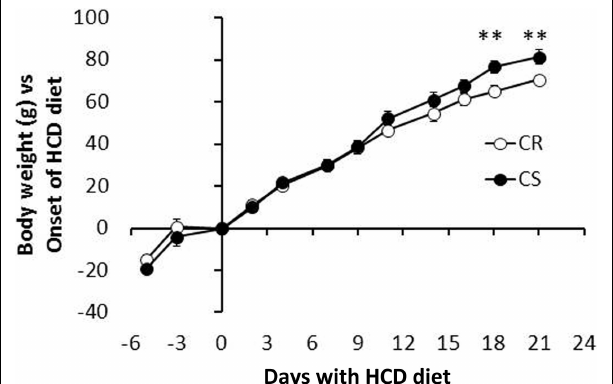
FIGURE 2 | Evolution of body weight: CR and CS rats had similar body weight at the onset of the study . Differences developed slowly and did not become significant before 21days (at the time rats were ~10weeks old). differencesinBWbetweenCSandCRratsbecamesignificantonly